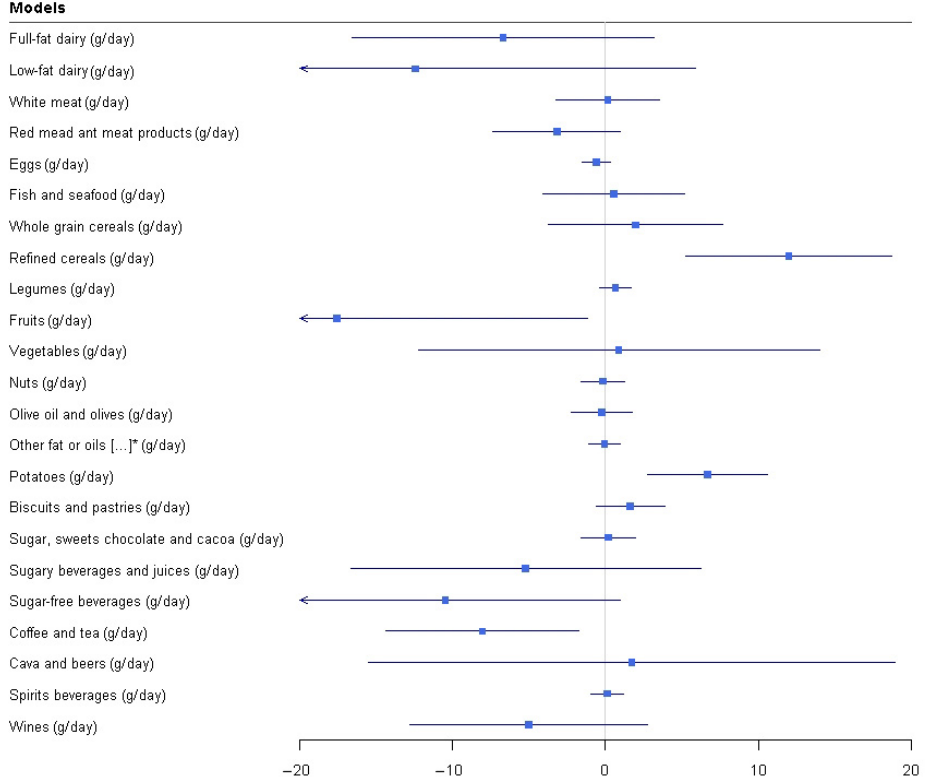
Figure 1. Relationship between CSI and food groups consumption. * other fat or oils, full-fat dairy derivatives and processed meal Multiple linear regressions. CSI (low high deprivation index) as exposure and food consumption (food groups, g/d) as outcome adjusted by age (years), sex (men/women). Somking (smoker, former or never smoked), waist circumference (cm). physical activity (low/high), sedentary lifestyle (no/yes), hypertension(no/yes), dyslipidemia (no/yes), dyslipidemia (no/yes), and type 2 diabetes mellitus.